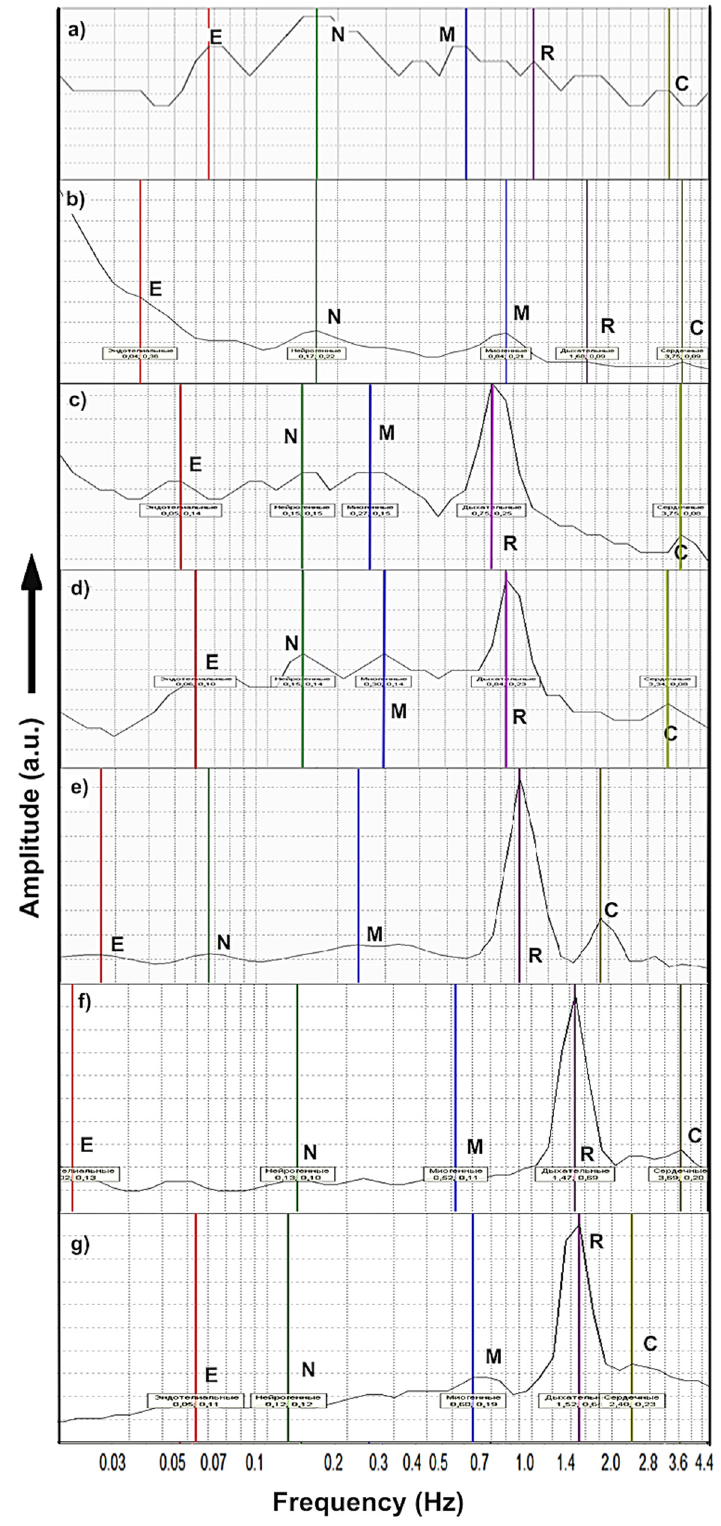
Figure 1. Wavelet-LDF spectra obtained immediately after a burn (Day 0 ( a ) and Day 10 ( b )) and after treatment of burn wounds on Day 10 with: Oleogel ZnO-BDP ( c ), BC-ZnO ( d ), BC-ZnO-BDP (Day 10 ( e ) and Day 21 ( f )). Typical spectrum of intact rats ( g ). E—endothelial, N—neurogenic, M— myogenic, R—respiratory, and C—cardiac factors.